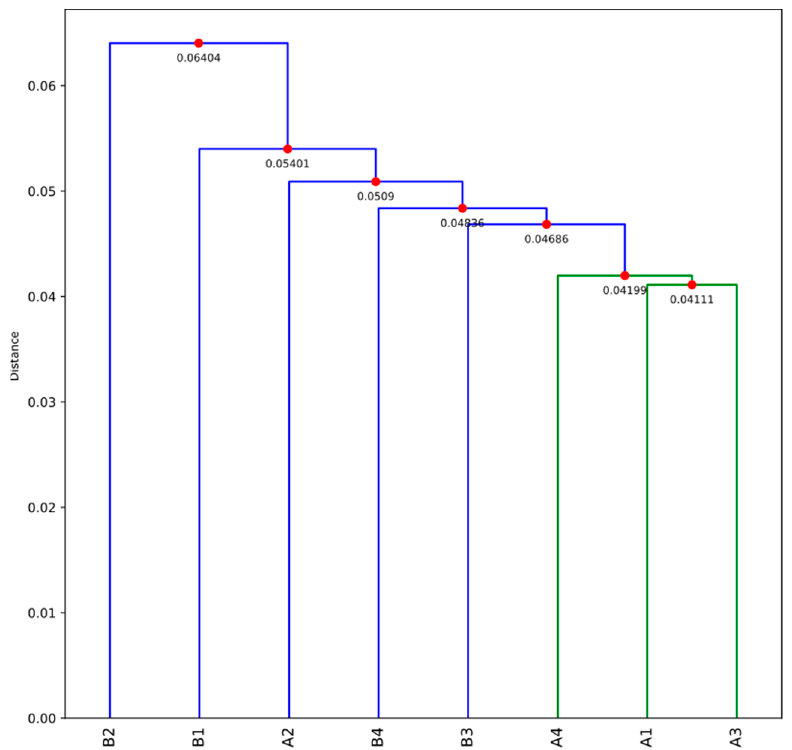
Figure 11. Dendrogram of the unblended A/B chunks.